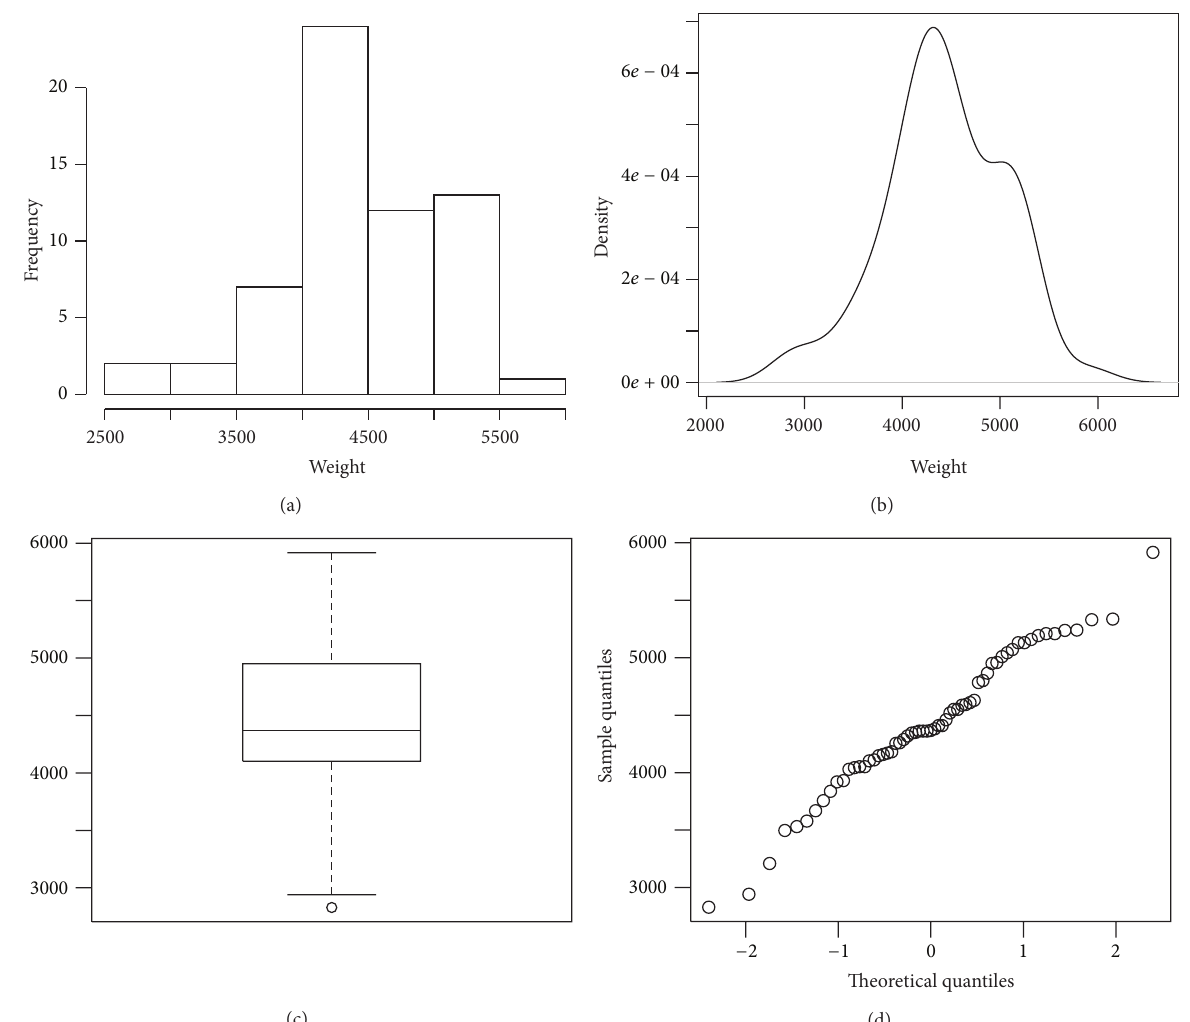
Figure 3: (a) Histogram, (b) density plot, (c) Box-and-Whisker plot, and (d) normal quantile-quantile plot of the weights of 61 one-month old